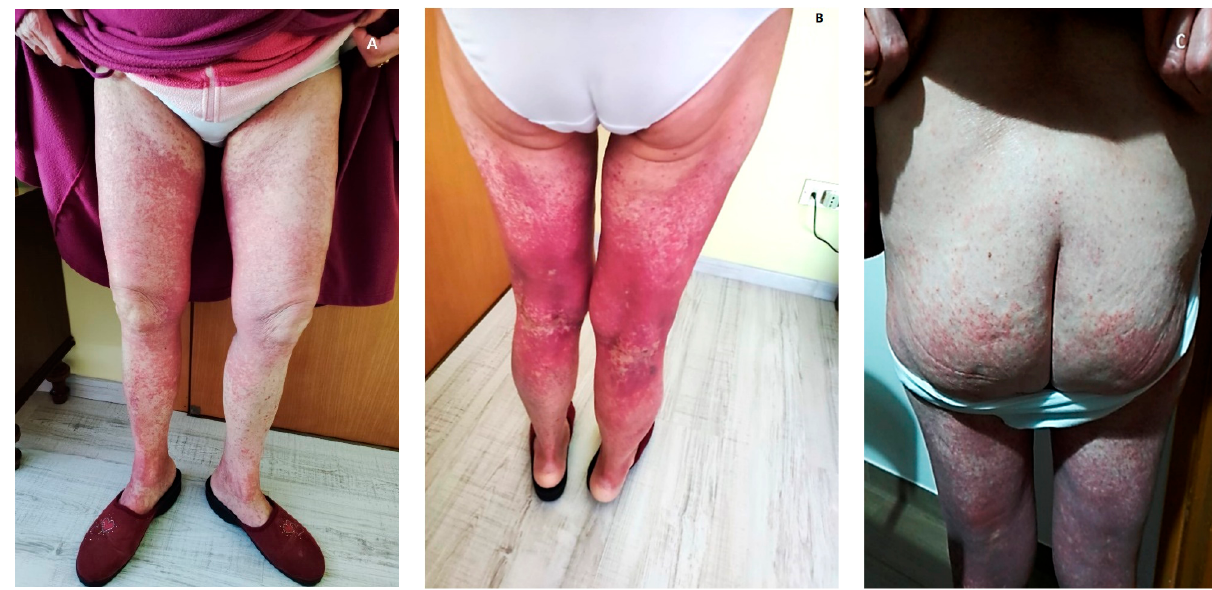
Figure 1. diffuse, non-whitening, maculopapular rash in both lower extremities. Figure 1. ( A – C ) Diffuse, non-whitening, maculopapular rash in both lower